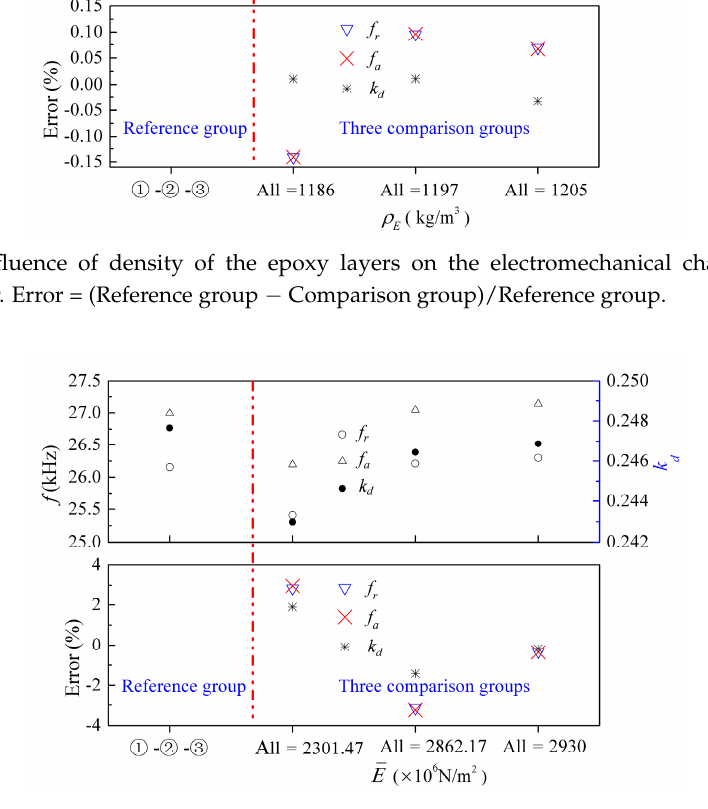
Figure 7. Influence of density of the epoxy layers on the electromechanical characteristics of the transducer. Error = (Reference group − Comparison group)/Reference group.